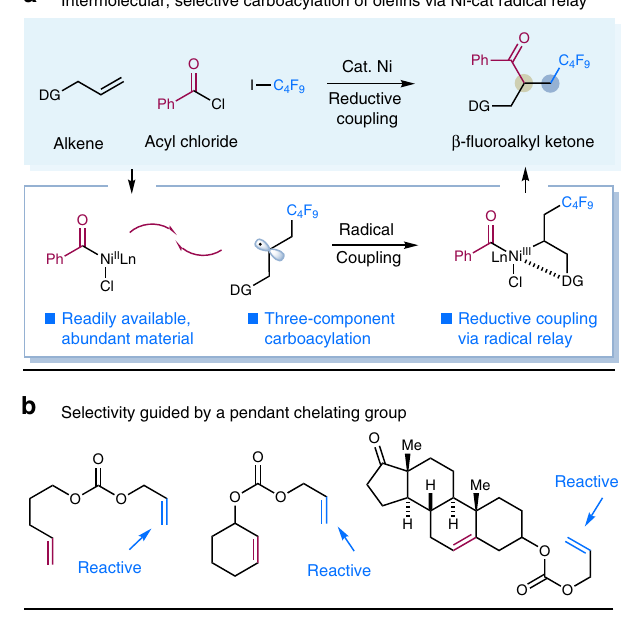
Fig. 1 Design of an intermolecular, selective carboacylation of alkenes. a Three-component carboacylation of ole fi ns via nickel-catalyzed reductive radical relay. b Selectivity guided by a chelating